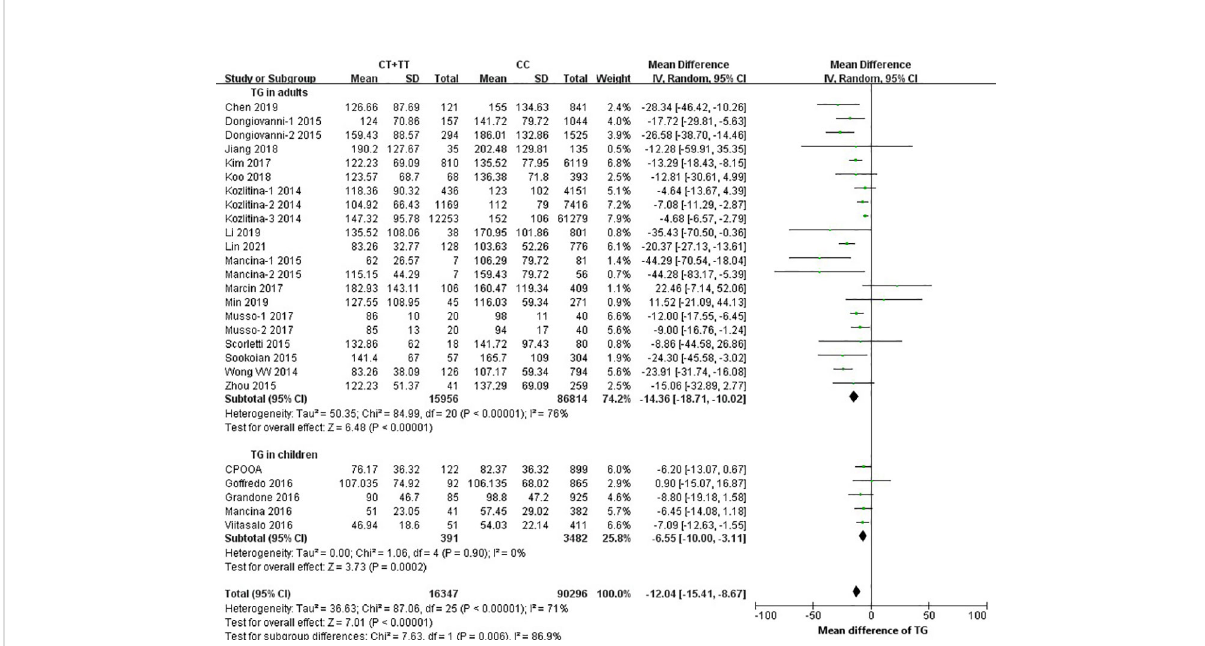
FIGURE 4 rs58542926 T allele associated with lower TG. Data from 106,643 individuals (102,770 adults, 3873 children). rs58542926 T allele was positively associated with TG in both adults and children (using a dominant model of inheritance), where data represent SD change in TG (mg/dl) per T- allele. Meta-analysis was performed using random effects with the DerSimonian − Laird method for estimation of tau 2 ; TG, triglyceride; CI, con fi dence interval; SE, standard